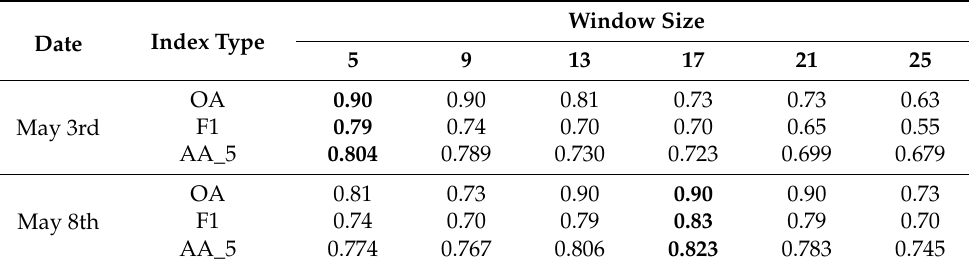
Figure 9. Detection results on May 8 ( a ) window size = 5 × 5, ( b ) window size = 9 × 9, ( c ) window size = 13 × 13, ( d ) window size = 17 × 17, ( e ) window size = 21 × 21, and ( f ) window size = 25 × 25. Table 3. Overall accuracy (OA), F1-score (F1), and average OA values obtained in the five-fold cross-validation (AA_5) of the two models on different